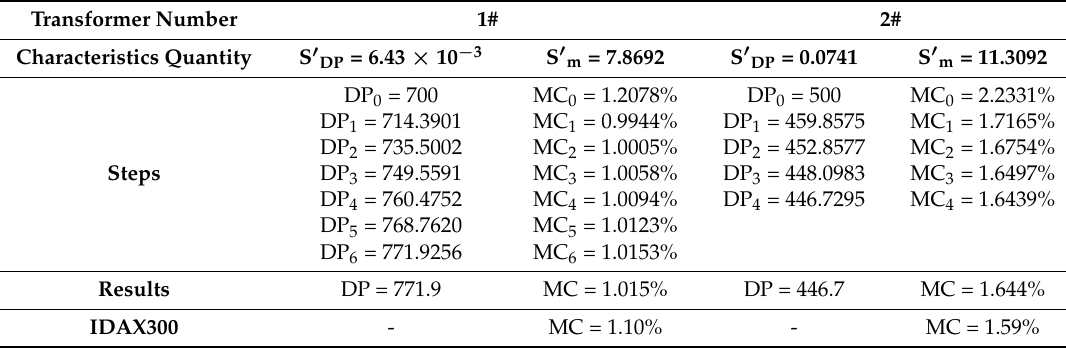
Table 7. Field transformer insulation state evaluation results based on compensation factor.